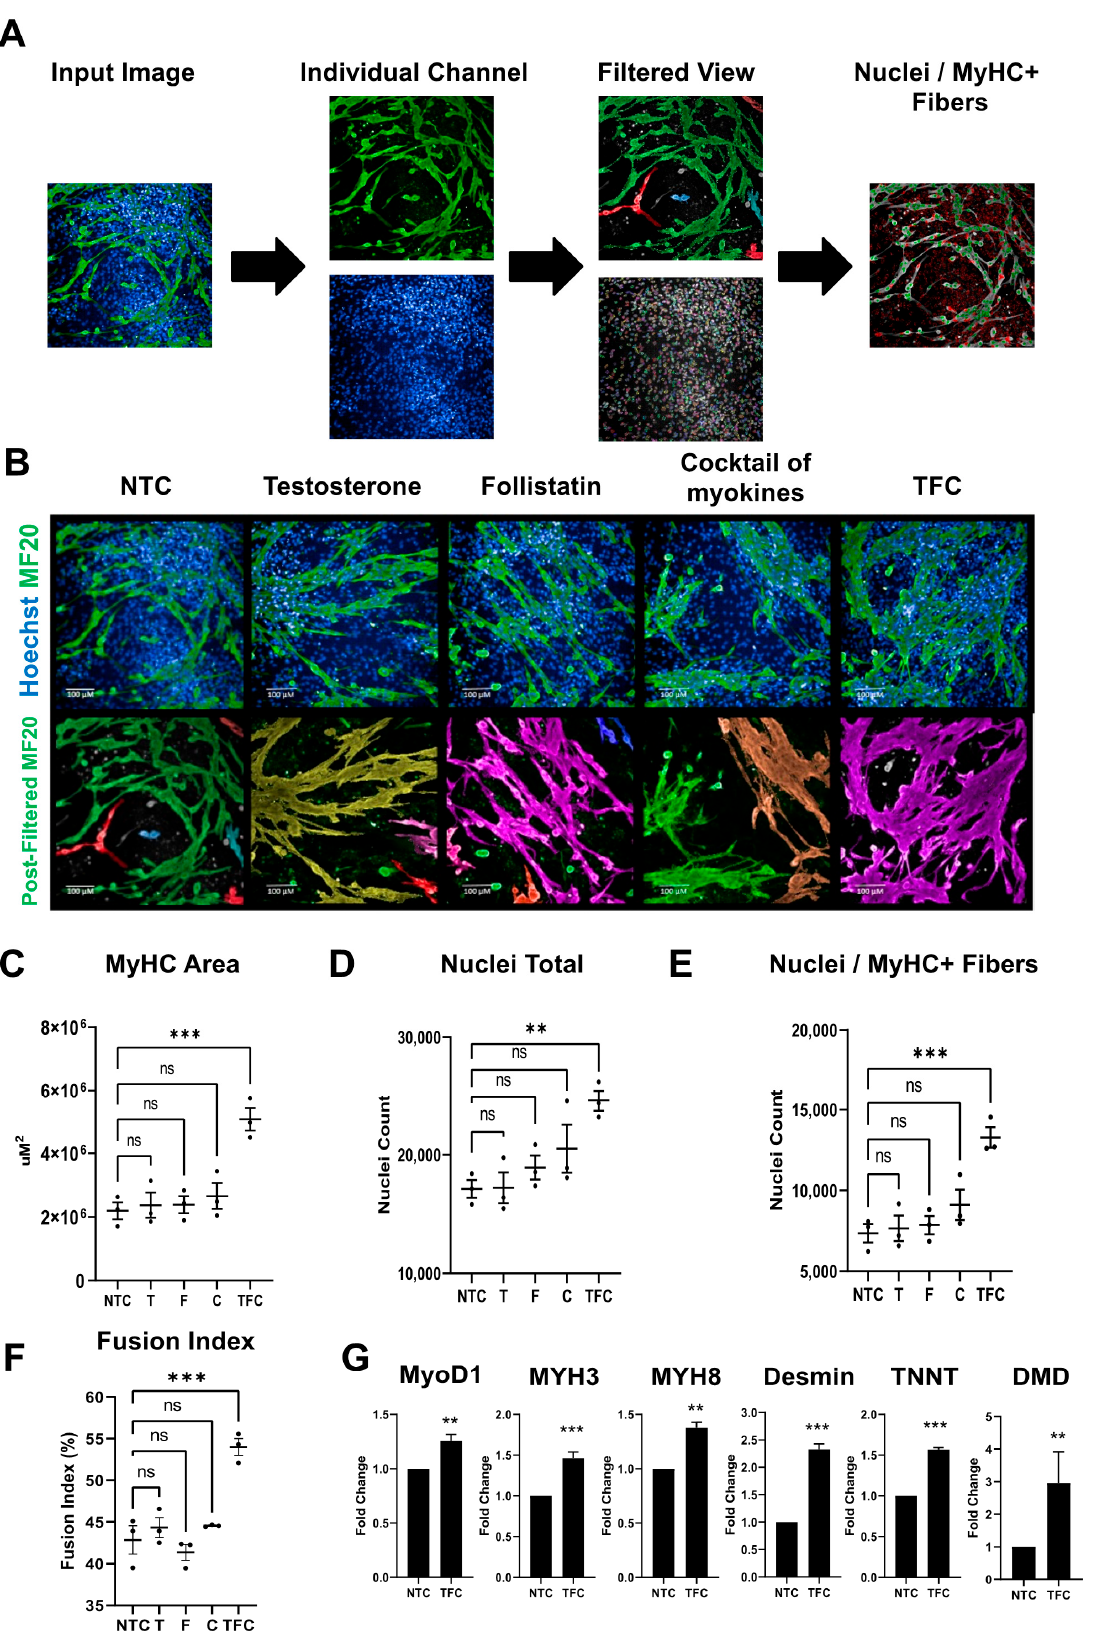
Figure 2. Anabolic factors and myokines enhance terminal differentiation of hESC-SkMC. ( A ) Image analysis pipeline. ( B ) Example pre- and post-filtered images of untreated and treated hESC-SkMC.